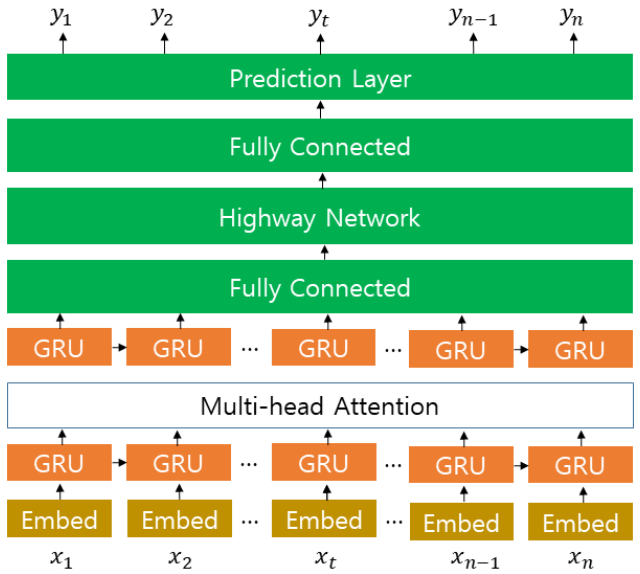
Figure 6. Structure of Bi-GRU-Attention-based rhyme sphere boundary prediction model.